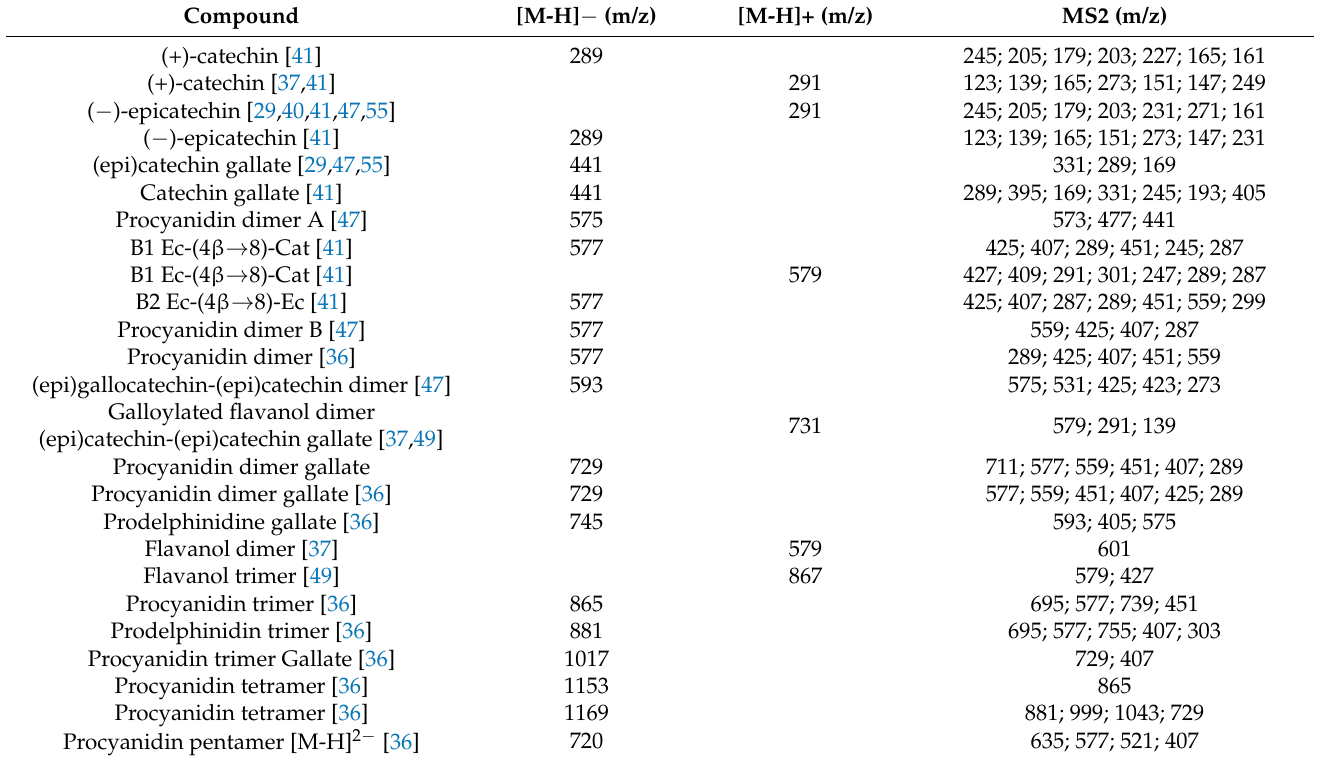
Table 6. Identification of flavan-3-ols and proanthocyanidins in grape stem extracts